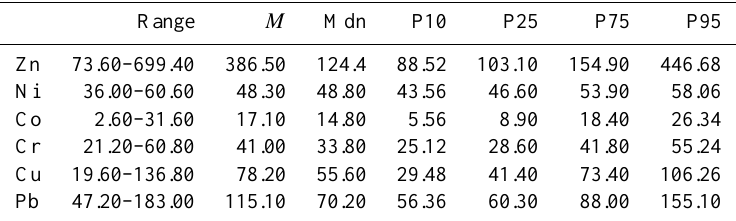
Table 3. Summary statistics of the chemical data.